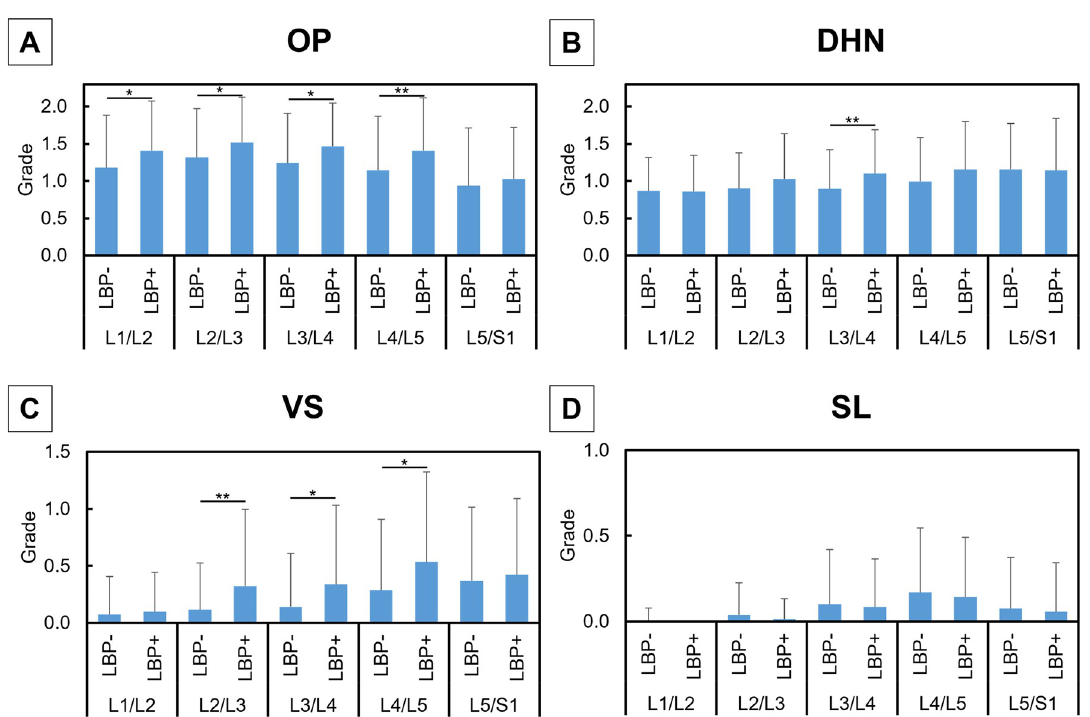
Fig 3. Grades of radiographic features with or without low back pain. Mean grades in the osteophytes (OP) ( A ), disc height narrowing (DHN) ( B ), vertebral sclerosis (VS) ( C ), and spondylolisthesis (SL) ( D ) with low back pain (LBP+) or without LBP (LBP-) at each intervertebral level are shown. Grades in each radiographic feature between the two groups were compared using the Mann- Whitney test. Data are expressed as mean ± standard deviation. � P < 0.05 and �� P < 0.01.